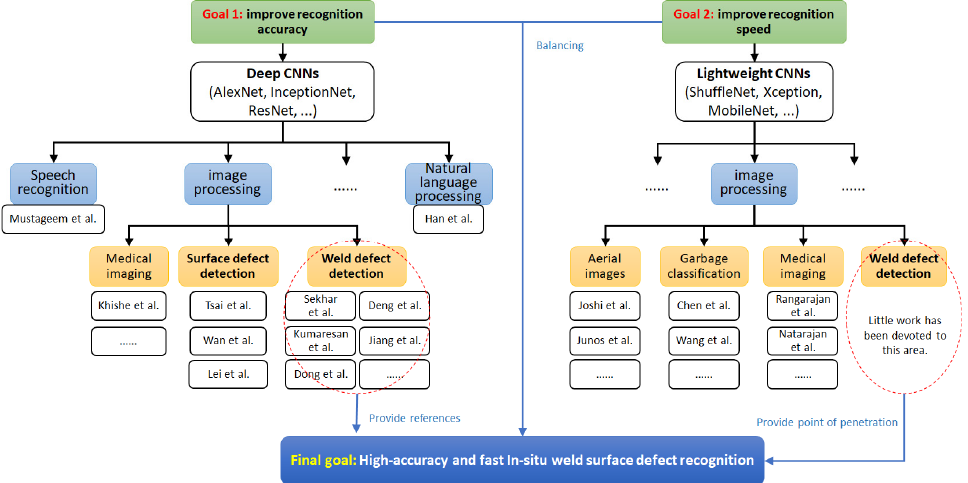
Figure 1. Analytic flow of related work.